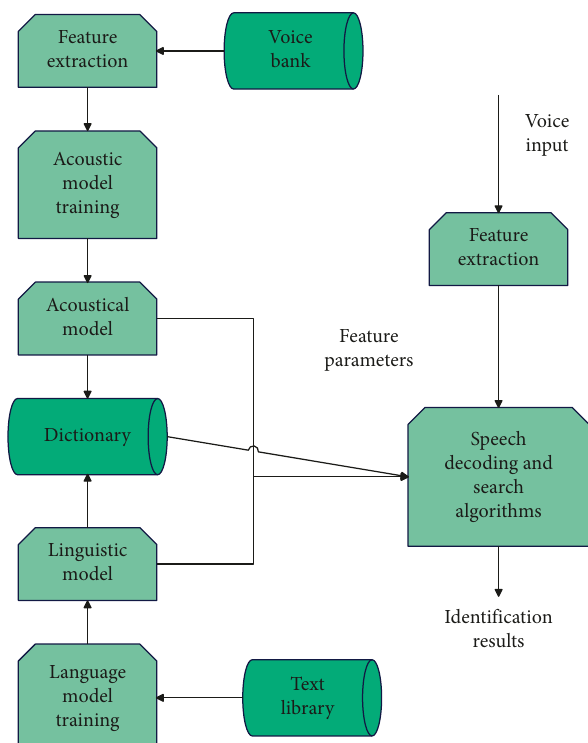
Figure 6: The digital teaching platform for spoken English based on virtual reality.